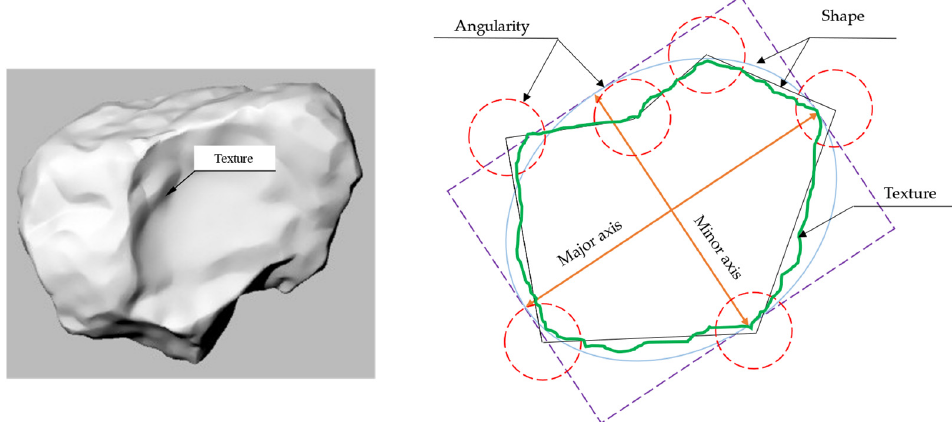
Figure 2. Relationship among shape, angularity and surface texture.